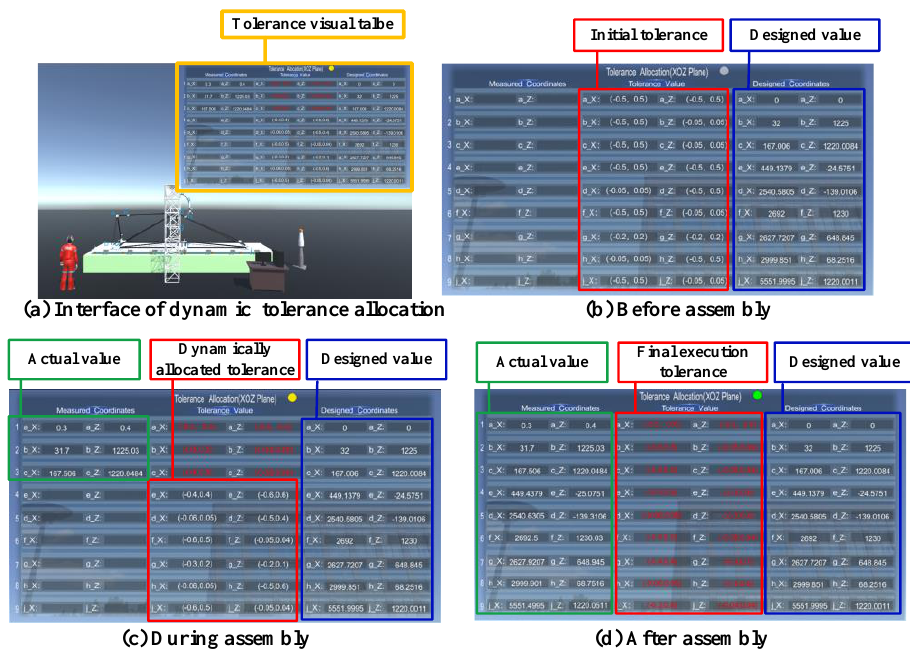
Figure 15. Tolerance collaborative allocation software.